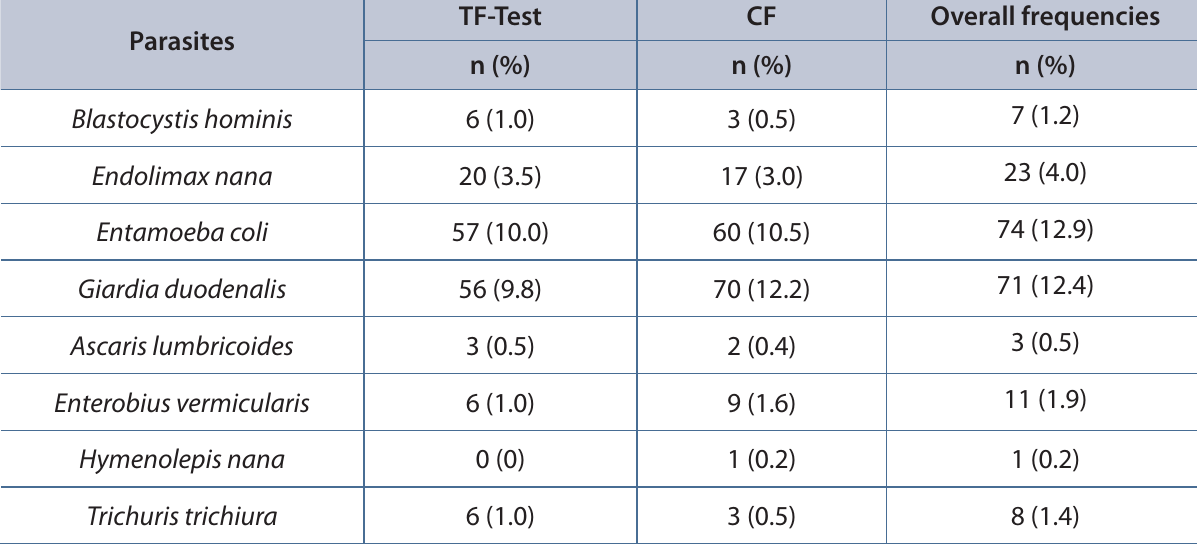
Table 1. Frequency of intestinal parasites and commensals detected by centrifugal flotation (CF) and TF- Test kit® (TF) in fecal samples from 573 children in São Paulo state,